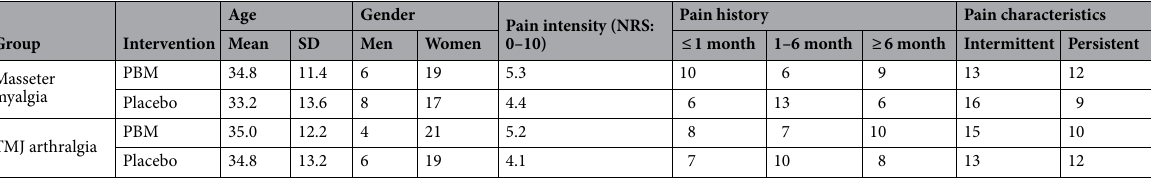
Table 1. Clinic characteristics of participants in different groups. PBM: